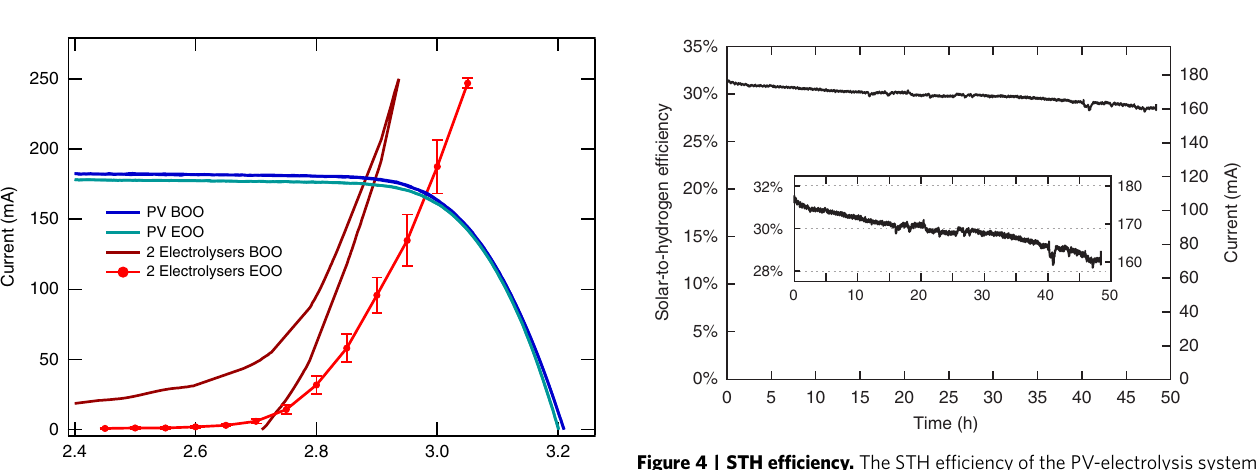
cell voltage ( V MPP ) output is 2.91 V and the current density ( J MPP ) 39% under these operating conditions. The I – V characteristics of the dual electrolyser and the solar cell, measured before and after the 48 h operation, are shown in Fig. 3. The cross-point of a dual- electrolyser I – V curve and a solar cell I – V curve is the system- coupling point and indicates the operating voltage ( V OP ) and current ( I OP ) for the system. It can be seen that at the beginning of operation, V OP is slightly lower than V MPP . At the end of operation, as the activity of the dual-electrolyser decreases, V OP is slightly higher than V MPP . The decrease in electrolyser perfor-